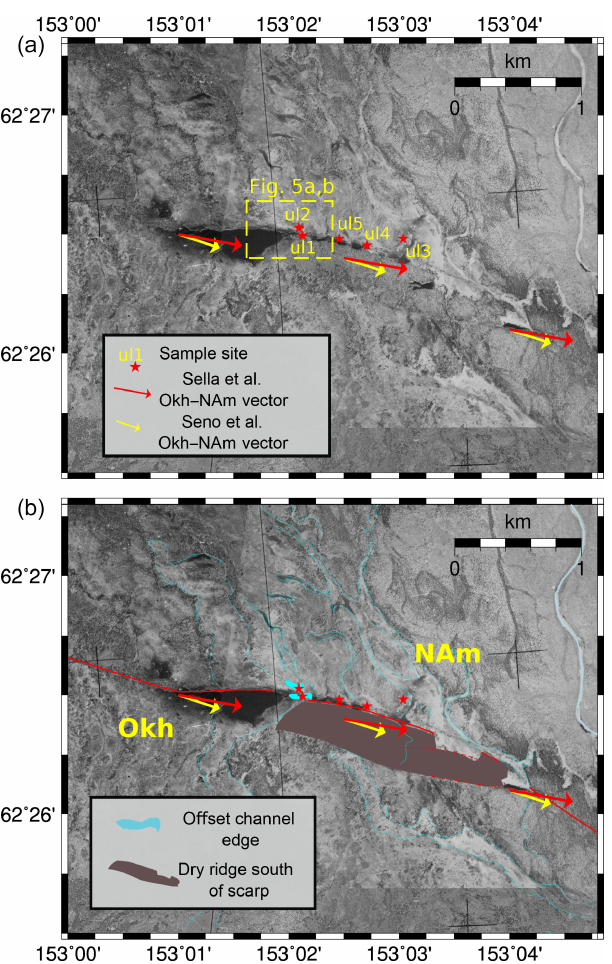
Figure 4. (a) Un-interpreted aerial photo picture of ridge and scarp, showing sample localities (red stars) and names. Outline of Fig. 5 indicated. (b) Interpreted image showing ridge area south of scarp (dark shaded), fossil channel system (light blue outline) and offset channel bank feature (light blue solid shading). Also shown are lin- ear velocity vectors based on Okh–NAm poles of Sella et al. (2002) and Seno et al. (1996). Figure 5. (a) Magnification of aerial photo showing interpreted,